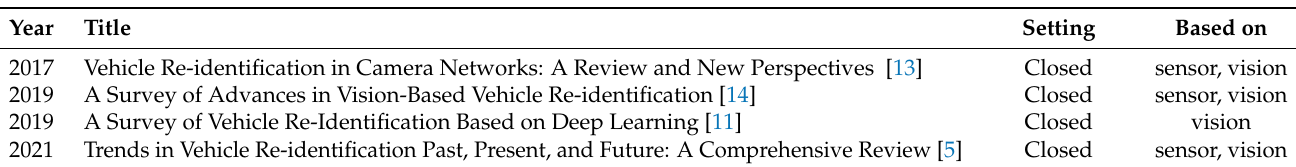
Table 1. Surveys on vehicle re-identification.